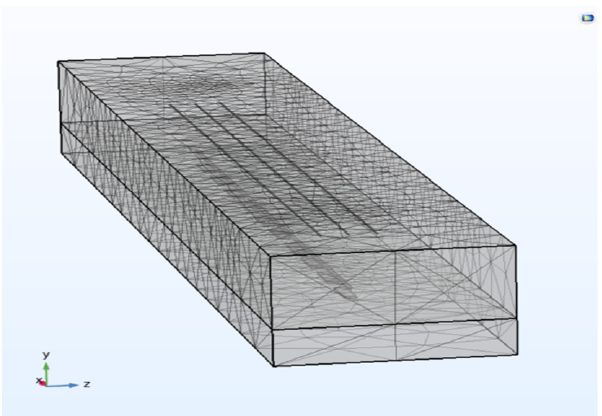
Figure 4. Grid division diagram.